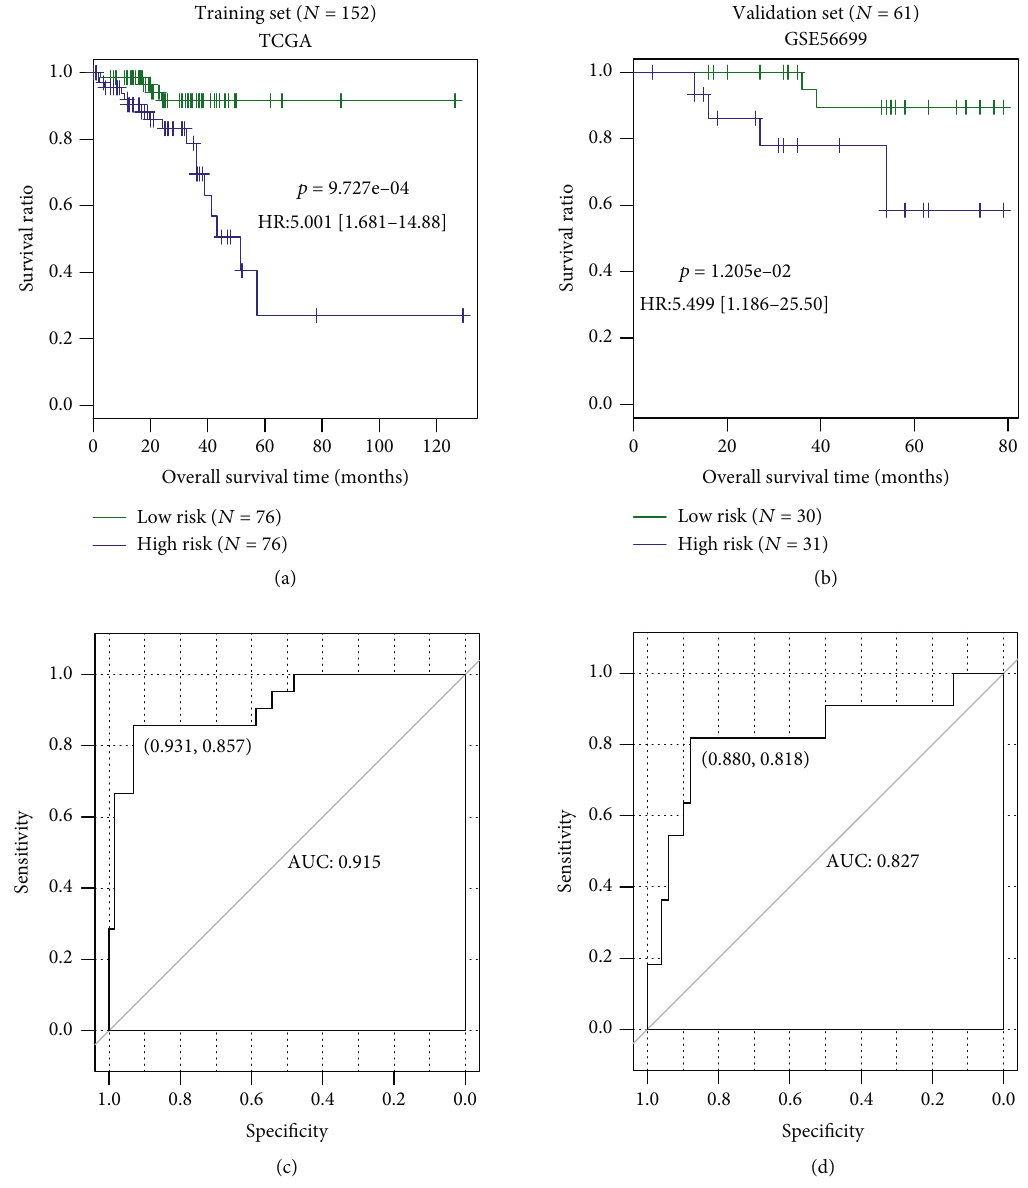
Figure 4: The prognostic performance of the 5-gene risk score model. (a, b) The Kaplan-Meier survival curve to show the overall survival di ff erences of patients with the high-risk score and the low-risk score in TCGA (a) and GSE56699 (b) datasets. (c, d) The ROC to demonstrate the prognostic accuracy of the risk score for the overall survival of patients in TCGA (c) and GSE56699 (d) datasets. TCGA: The Cancer Genome Atlas; HR: hazard ratio; AUC: area under the receiver operating characteristic (ROC)